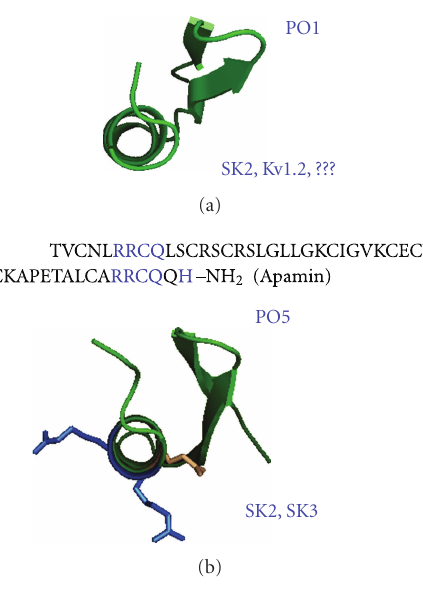
Figure 2: Amino acid sequences and 3D structures of P01 and P05. (a) Amino acid sequence (single letter notation) and 3D structure of P01 [26, 28]. (b) Amino acid sequence (single letter notation) of P05 compared to that of the bee venom apamin (18 mers peptide). Amino acids common to P05 and apamin and crucial for the SK Ca blockade are in blue. These amino acids are materialized on the 3D structure of P05, view by the α -helix axe. The two positive Arg are in blue and the neutral Gln is in brown.